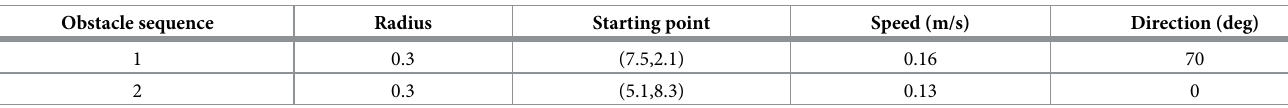
Table 5. The characteristic of linear movement obstacles.